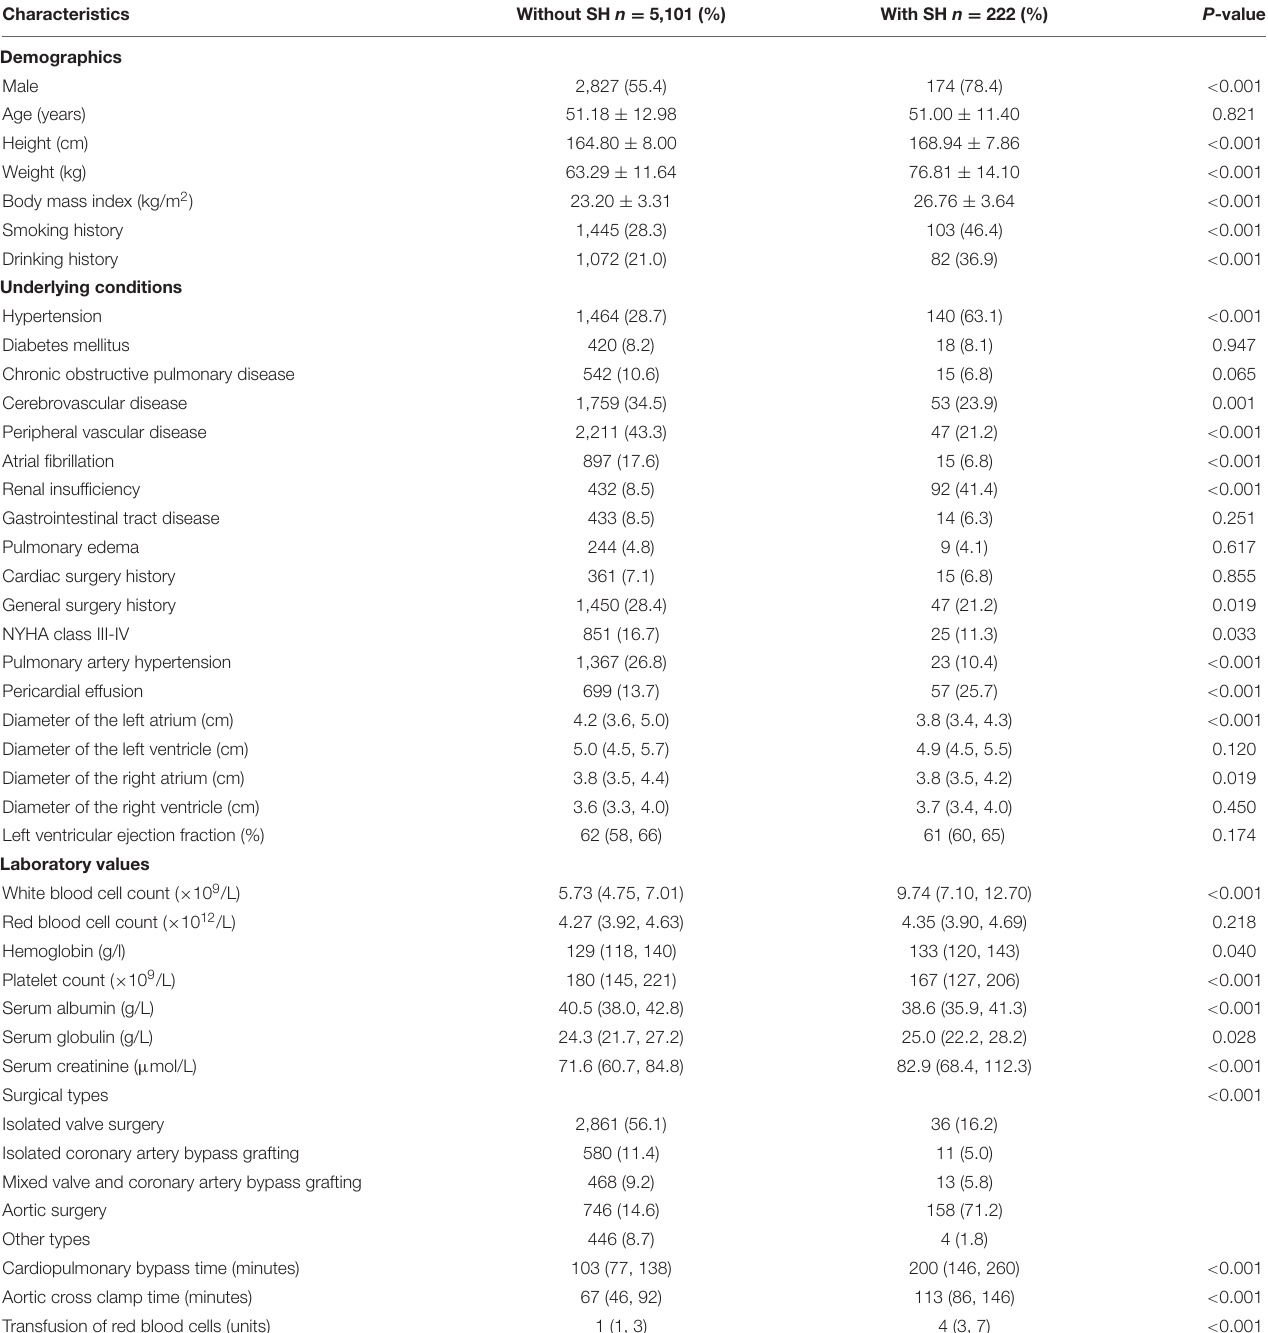
TABLE 1 | The univariate analysis of possible risk factors for SH after cardiac surgery. Characteristics Without SH n = 5,101 (%) With SH n = 222 (%) P